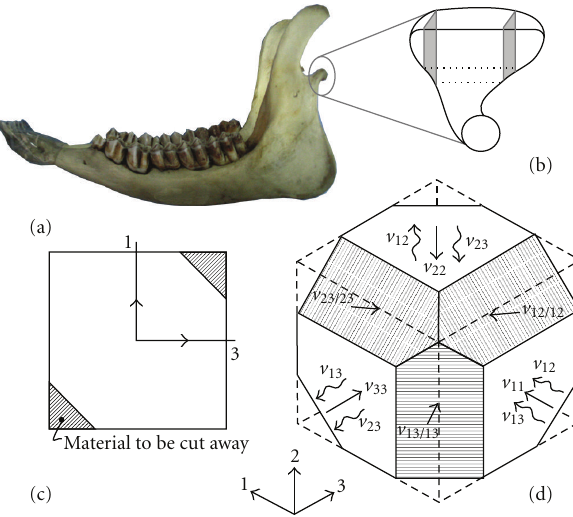
Figure 1: An illustration of the ultrasonic measurement process of sheep condyle. (a) Anatomic sketch of sheep mandible and condyle. (b) Condyle sample prepared for ultrasonic measurement. (c) Two-dimensional illustration of the bone material cut away so that v 13 / 13 can be measured. (d) A three-dimensional sketch of the bone sample after all the cuts have been made (shown as hatched parts) as well as the measurement direction for each v . 1 was the antero-posterior direction, 2 was the vertical direction, and 3 was the mesio-lateral direction. indicates longitudinal wave speed, which was measured with the generation and sensing transducer in line. indicates the transverse wave speed measured with the generation and sensing transducer at a right angle.